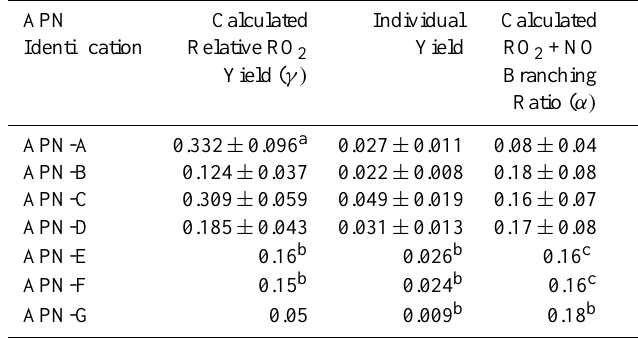
Table 1. α -Pinene hydroxy nitrate data.